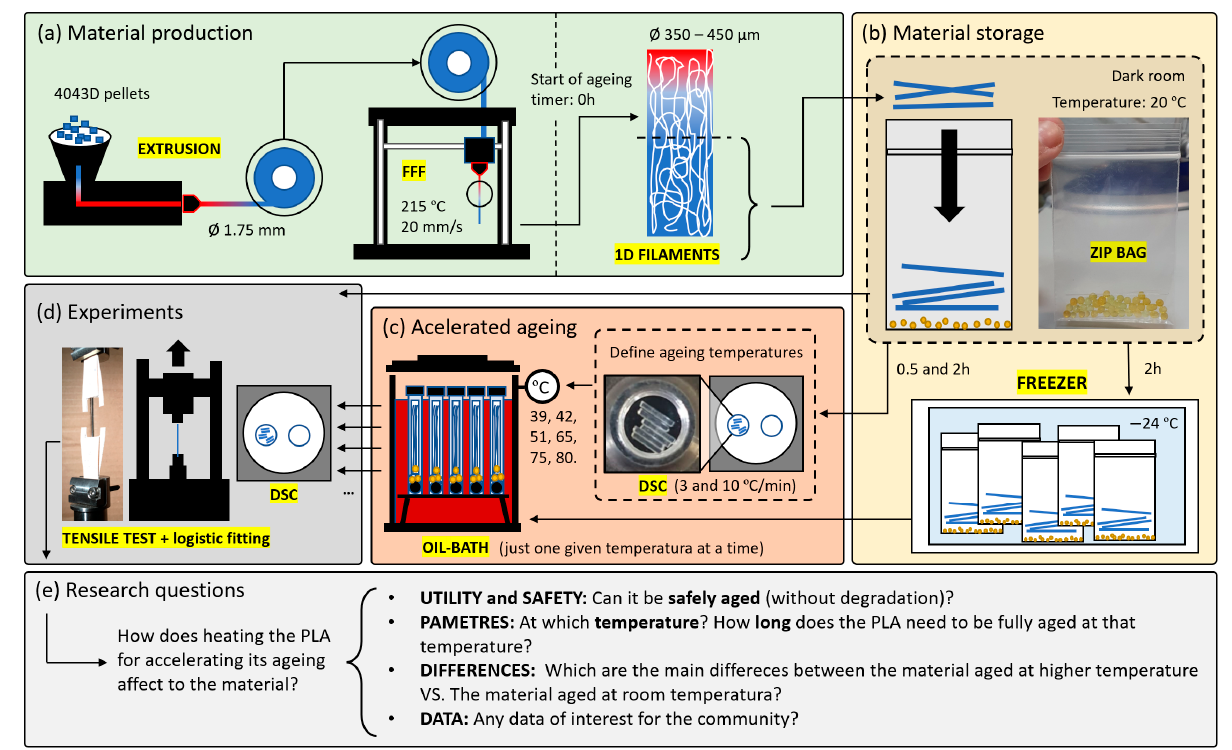
Figure 1. Workflow of the experiments performed: ( a ) production of PLA 1D filaments from pellets; ( b ) storage of PLA filaments; ( c ) accelerated ageing prior to definition of ageing temperatures with a DSC scan on the material right after it was printed; ( d ) experiments performed; ( e ) research questions.